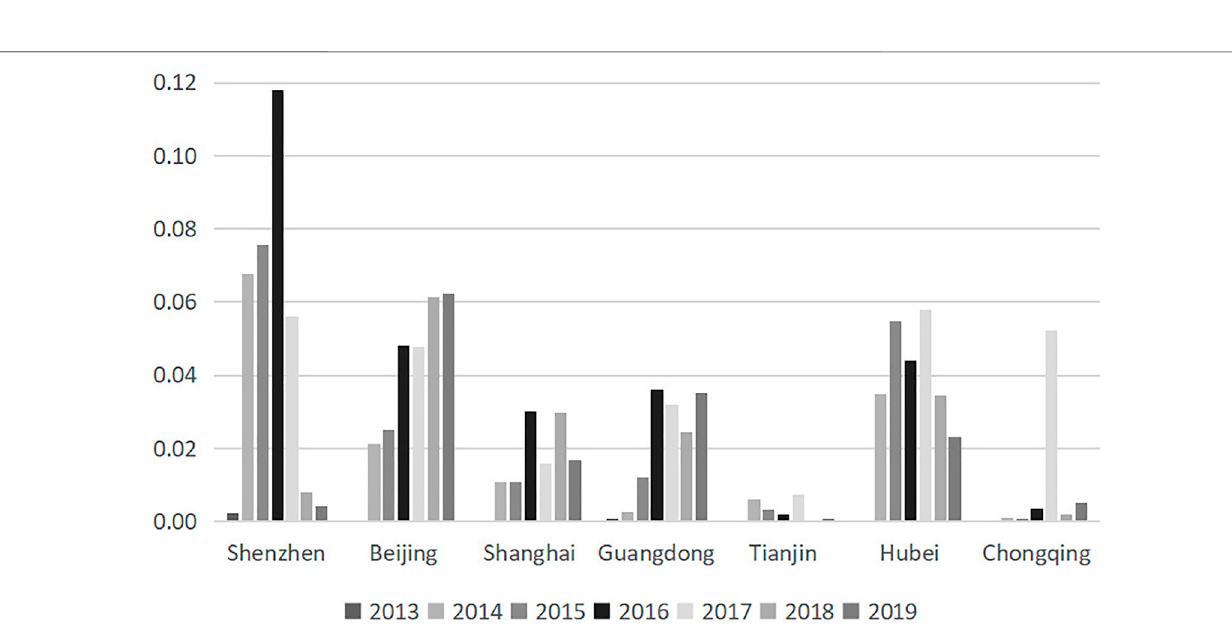
Frontiers in Environmental Science |